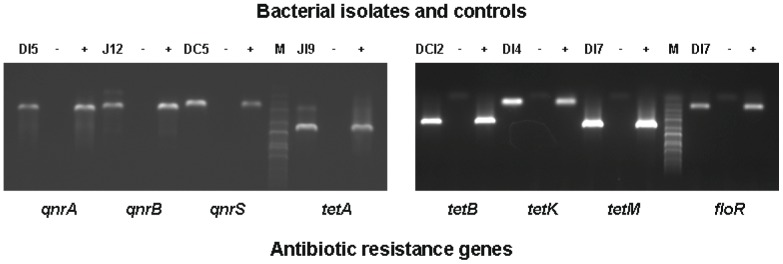
Antimicrobial resistance genes in unselected marine bacterial isolates and controls.Detection of antimicrobial resistance genes in bacteria cultured from marine sediments obtained from December, 2008, to January, 2009. qnr, tet and floR genes were detected by PCR as described in Material and Methods with primers in Table 3. D15, J12, DC5, J19, DC12, D14 and D17 are bacterial isolates from sediment. −, negative control (E. coli DH5α). +, positive controls (Table 3). M, molecular weight markers.